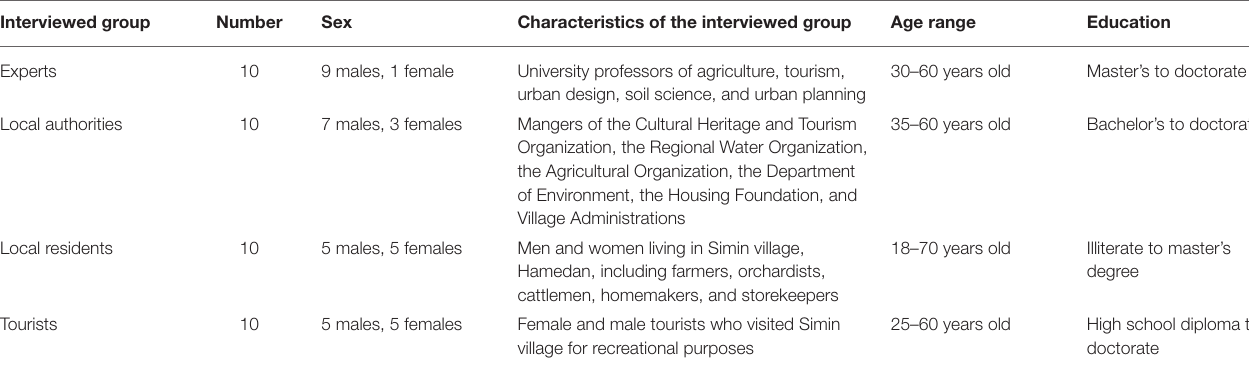
TABLE 1 | The demographic characteristics of the